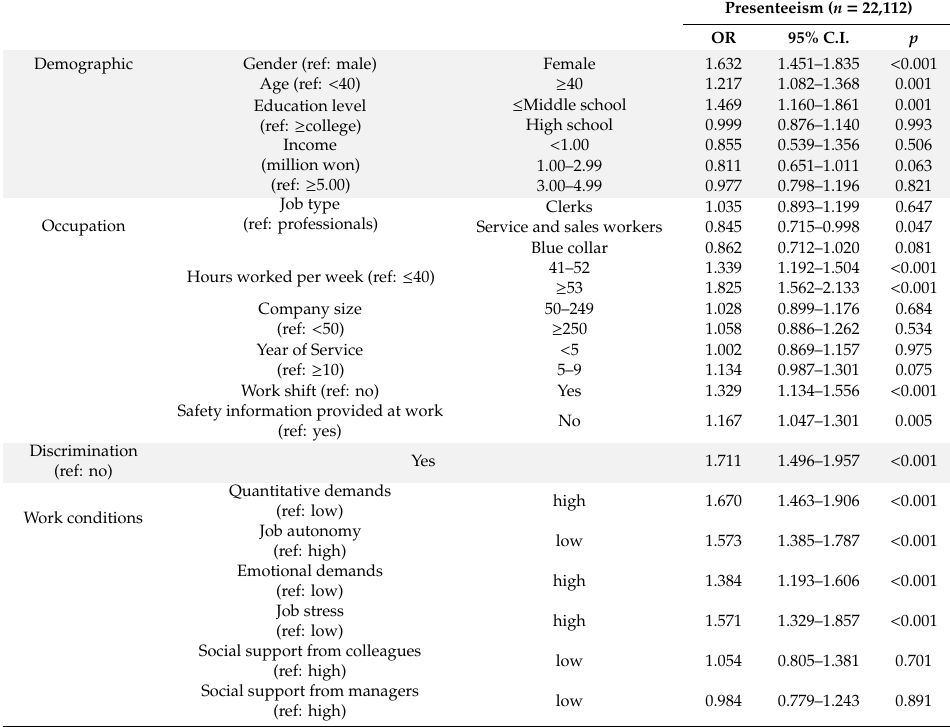
Table 4. Presenteeism among workers none exposed to adverse social